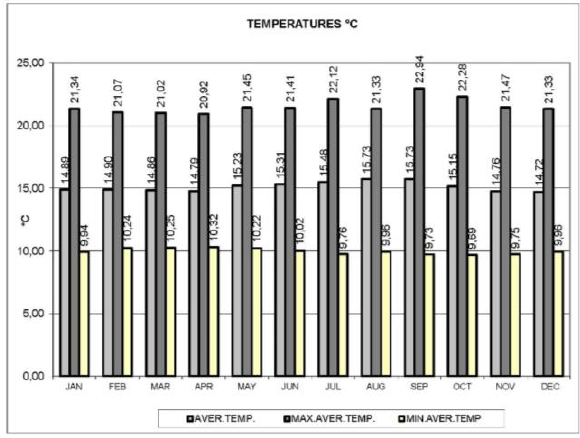
Table 1. Average temperature 2000-2012, INAMHI.